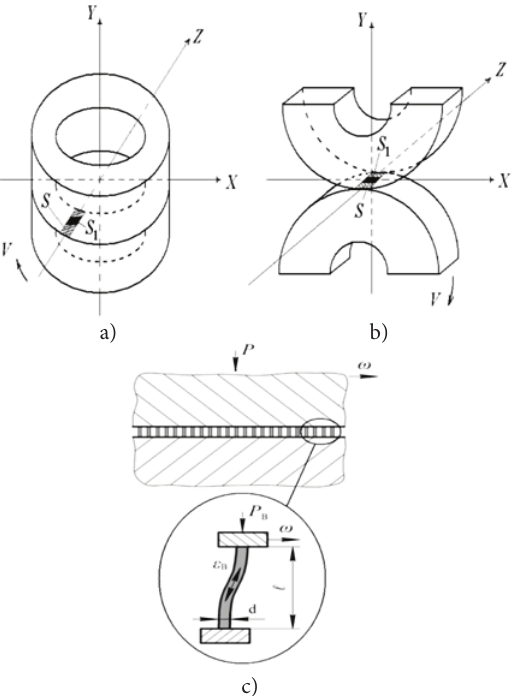
Fig. 1. A Kinematic scheme of friction units in the form of rings (a) and rollers (b), a scheme of friction contact and an idealized scheme of element destruction in the contact area (c): V indicates rotational velocity, S – the area of contact interaction; S 1 – the area on the contact surface; d – the size of composite material element on the contact surface; l – the length of the element; P , P B – indicate, respectively, the contact pressure of surfaces and the element on the contact surface, ω –